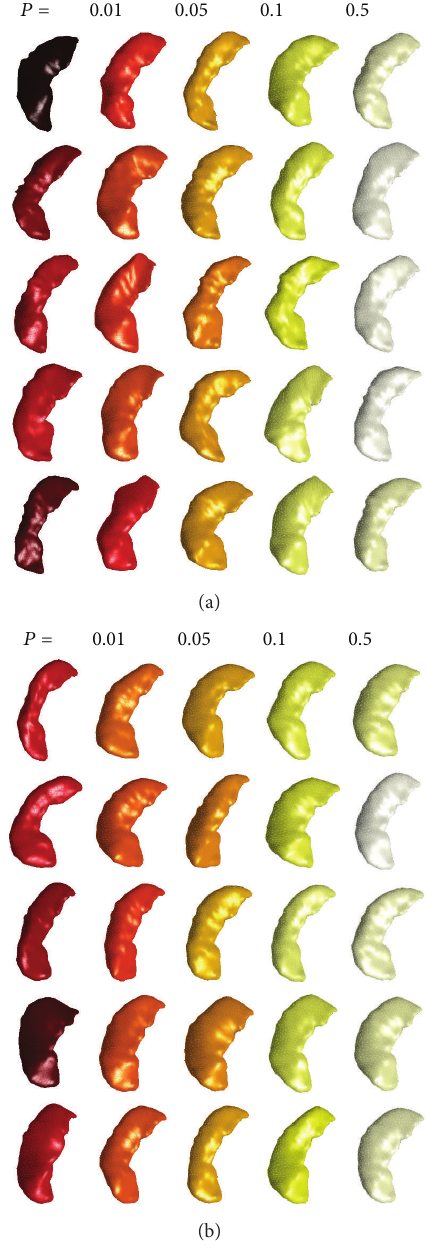
Figure 13: Population of left hippocampus surfaces binned by 𝑃 value from ADNI dataset. (a) Real patient data. (b) Simulated